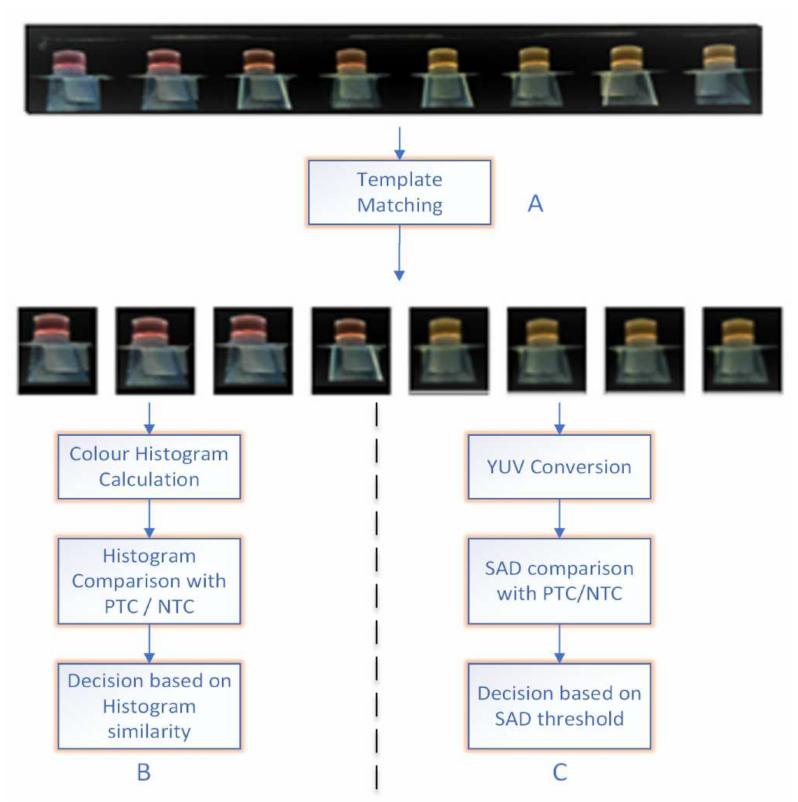
Figure 3. Overview of the different colorimetric approaches. ( A ) Template matching algorithm to extract test tubes. ( B ) Histogram-based classification approach. ( C ) YUV-based sum of absolute difference (SAD) approach.